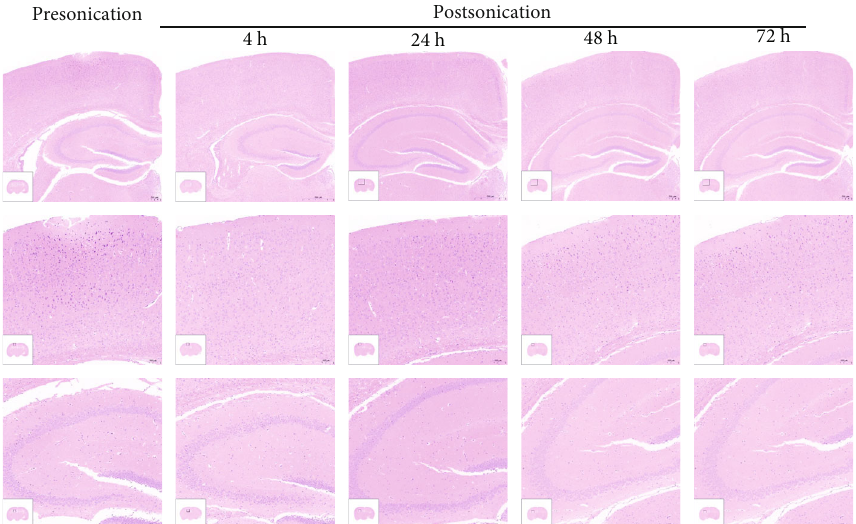
Figure 5: HE staining ((a) × 40, scale bar = 500 μ m; (b, c) × 100, scale bar = 100 μ m) shows that FUS-mediated BBB opening induced no edema, hemorrhage, or cell necrosis at 4, 24, 48, and 72 h